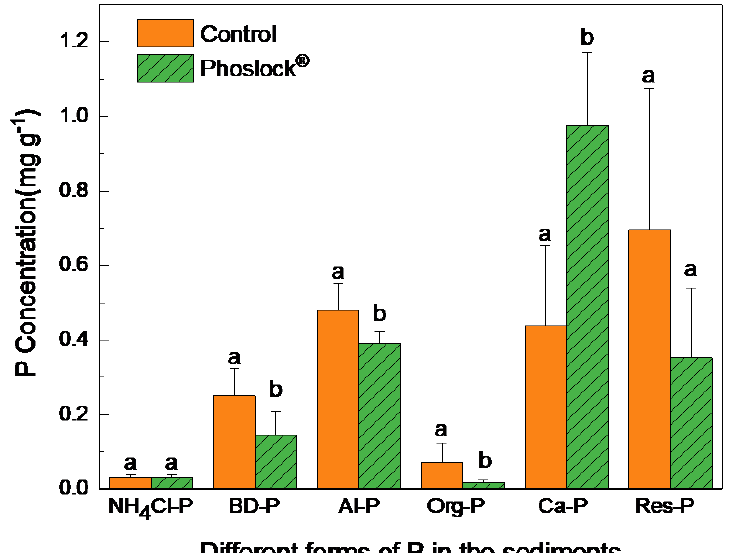
Figure 1. The contents of different forms of phosphorus in the sediments in the control (without Phoslock ® addition) and Phoslock ® (with Phoslock ® addition) treatment at the end of the experiment. Different letters indicate a significant difference between the two treatments at p < 0.05. Error bars represent the standard deviations